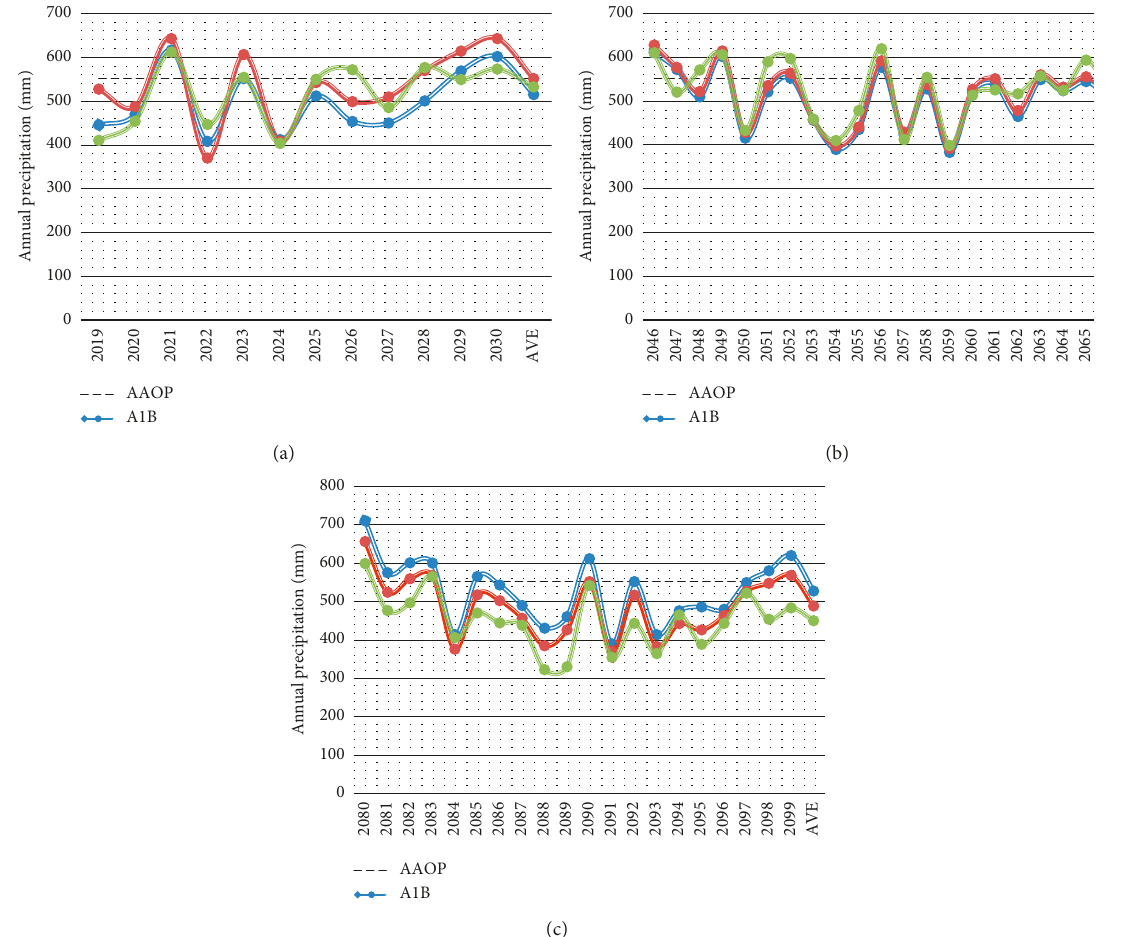
Figure 11: Changes in the averages of the annual rainfall in the future periods under ensemble model and three emission scenarios versus the observational values: (a) near future, (b) middle future, and (c) far